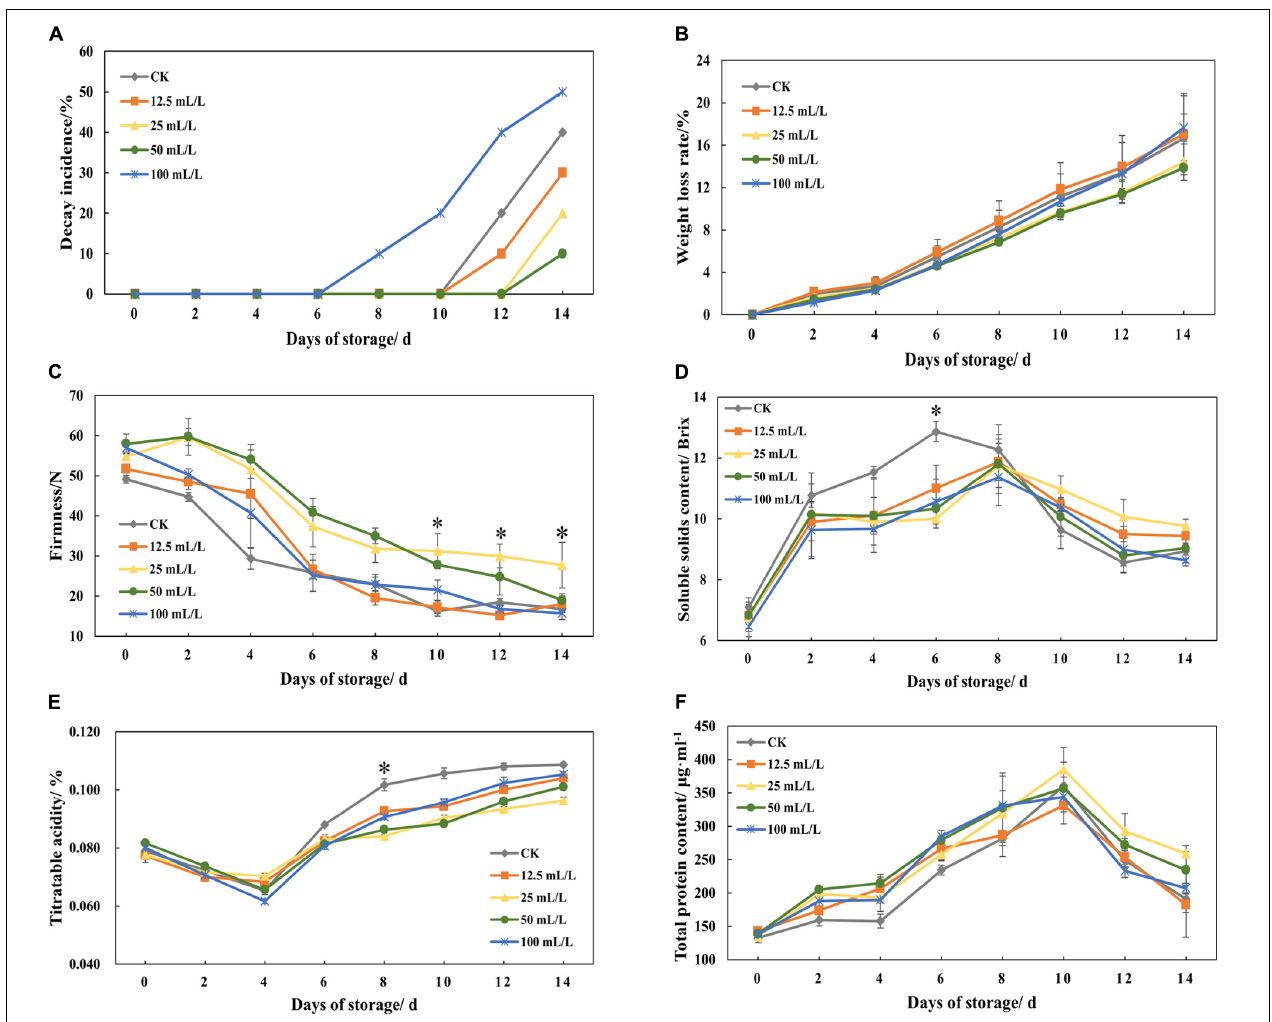
FIGURE 2 | (A) Decay incidence, (B) weight loss rate, (C) firmness, (D) soluble solids content, (E) titratable acidity, and (F) total protein content of papaya fruits treated with 0, 12.5, 25, 50, and 100 mL/L ethanol. Values are means ± SD. *Represents significant differences among the treatments ( p <